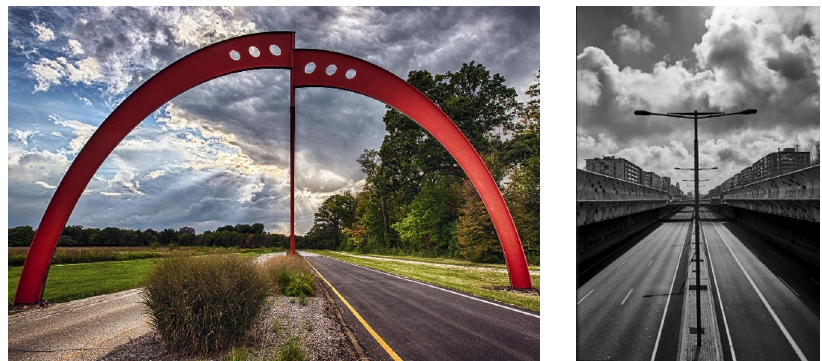
Figure 1 . Left: Soft explicit breaking of parity symmetry. The arcs are slightly asymmetric | soft explicit breaking. Right: Spontaneous breaking of parity symmetry. A day with clouds breaks the parity symmetry of the